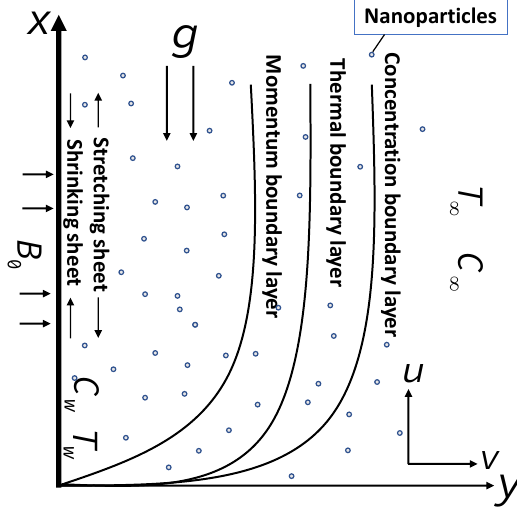
Figure 1. The coordinate system of the physical